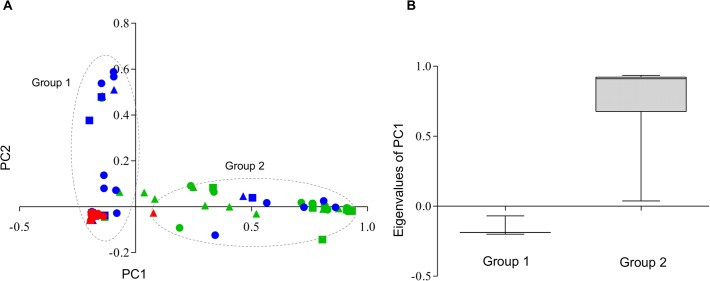
Principal coordinate analysis (PCoA) of combined COI-ND4 genes in Ae. aegypti mosquitoes of Colombia.(A) Dotted line represents inferred genetic group 1 and 2 of Colombian mosquitoes projected on the first (x-axis) and second principal coordinates (y-axis), which were derived from a PCoPA analysis. PC1 explains 79.2% of the variance whereas PC2 explains 8%; the color indicates the collection origin: BE (green), RI (blue) and VI (red); the circles, triangles and squares represent A, B, and C samplings, respectively (see Table 1 for details). (B) Box plot of PC1-eigenvalues of group 1 (n = 239) and group 2 (n = 58) derived from PCoA.